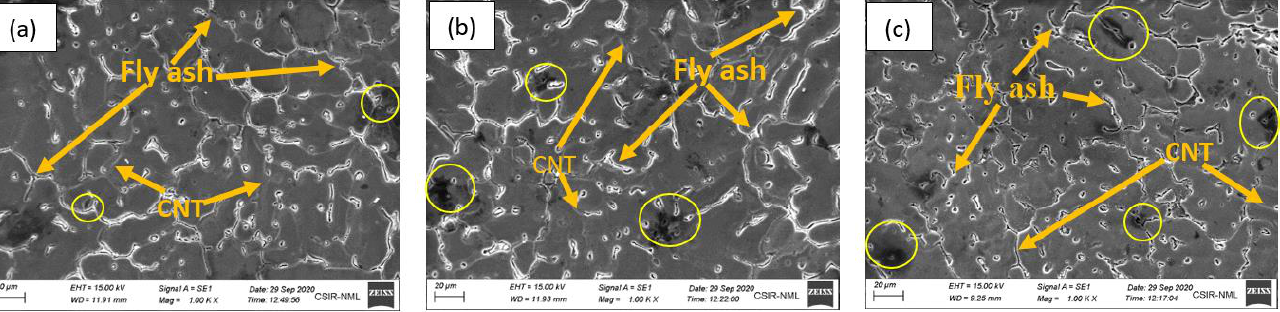
Figure 6. EDS analysis at grain boundary (Spectrum 41) and grain interior (Spectrum 42) of the composite. 3.2. Density of Composite Figure 7 shows the variation in measured density along with the porosity of the fab- ricated composite. These properties varied according to fly ash addition in the composite. Density decreases by the addition of the fly ash addition in the matrix phase. This is due to the comparatively low bulk density of the fly ash compared to aluminum, but the the- oretical density of the fly ash is higher than aluminum. Theoretical density was calculated